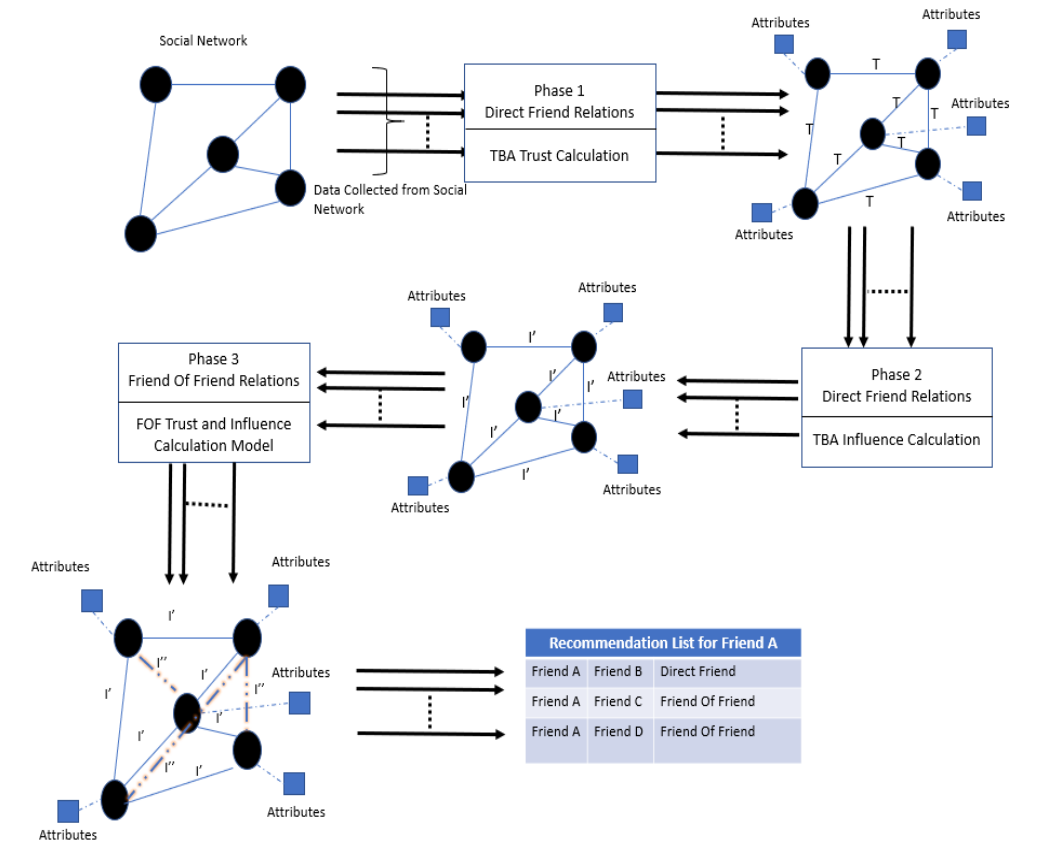
Figure 4. Friend-of-Friend social influence framework.